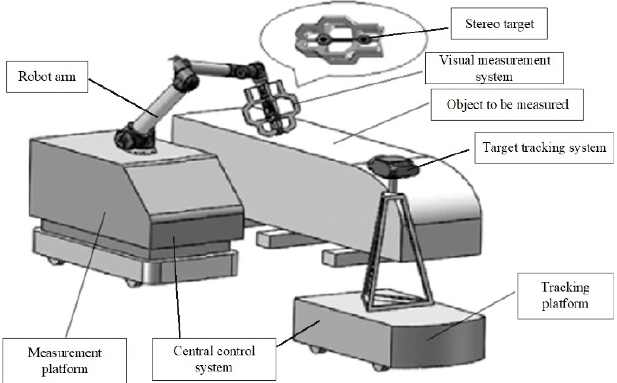
Figure 2. Schematic diagram of the hardware system.